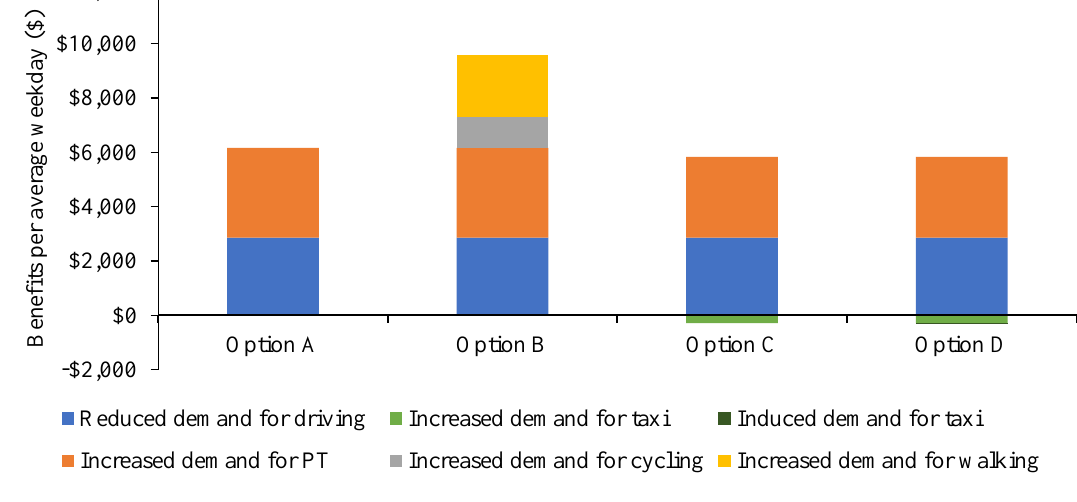
Figure 3. Benefit profile per option (September 2021 dollars, per average weekday)